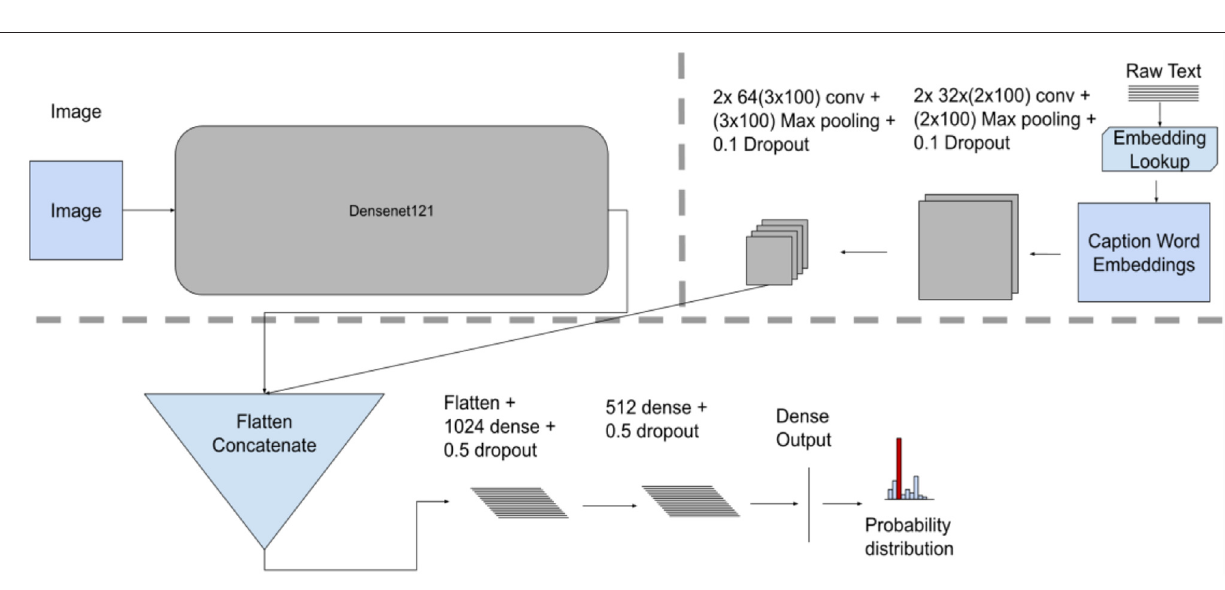
FIGURE 4 | Model fusion model architecture, showing individual unimodal CNN feature extractors for images and text along with the concatenation fusion mechanism, a terminal network consisting of three dense